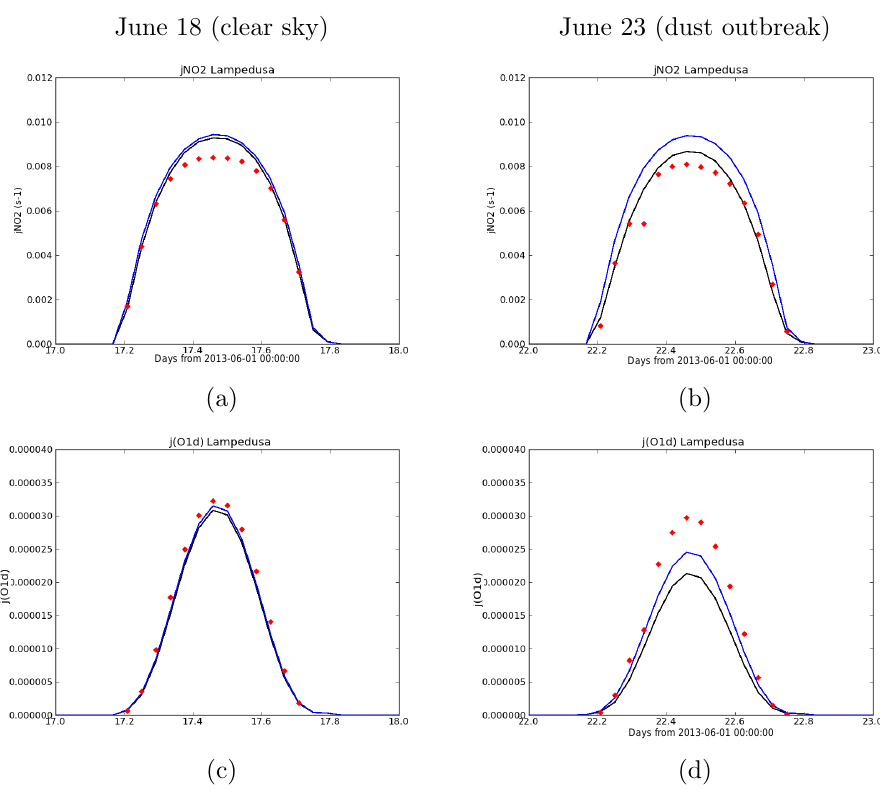
Figure 14. (a) Hourly modelled values of J( NO 2 ) in the REF simulation (black line) and in the NA simulation (blue line), and hourly measured values of J( NO 2 ) (red diamonds), for 18 June 2013. (b) Same as (a) but for 23 June; (c) hourly modelled values of J( O 1 D ) in the REF simulation (black line) and in the NA simulation (blue line), and hourly measured values of J( O 1 D ) (red diamonds), for 18 June 2013; (d) same as (c) but for 23